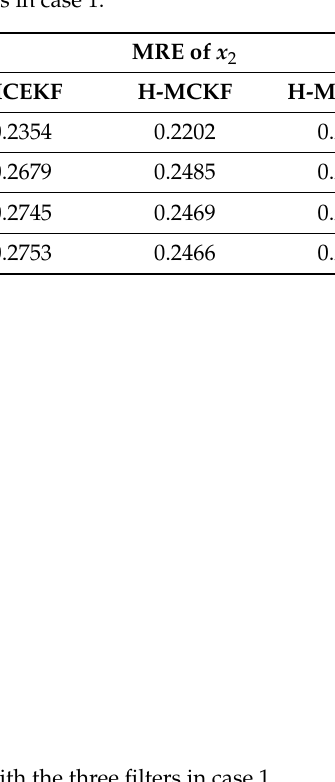
Table 2. The mean relative error using the three methods in case 1.